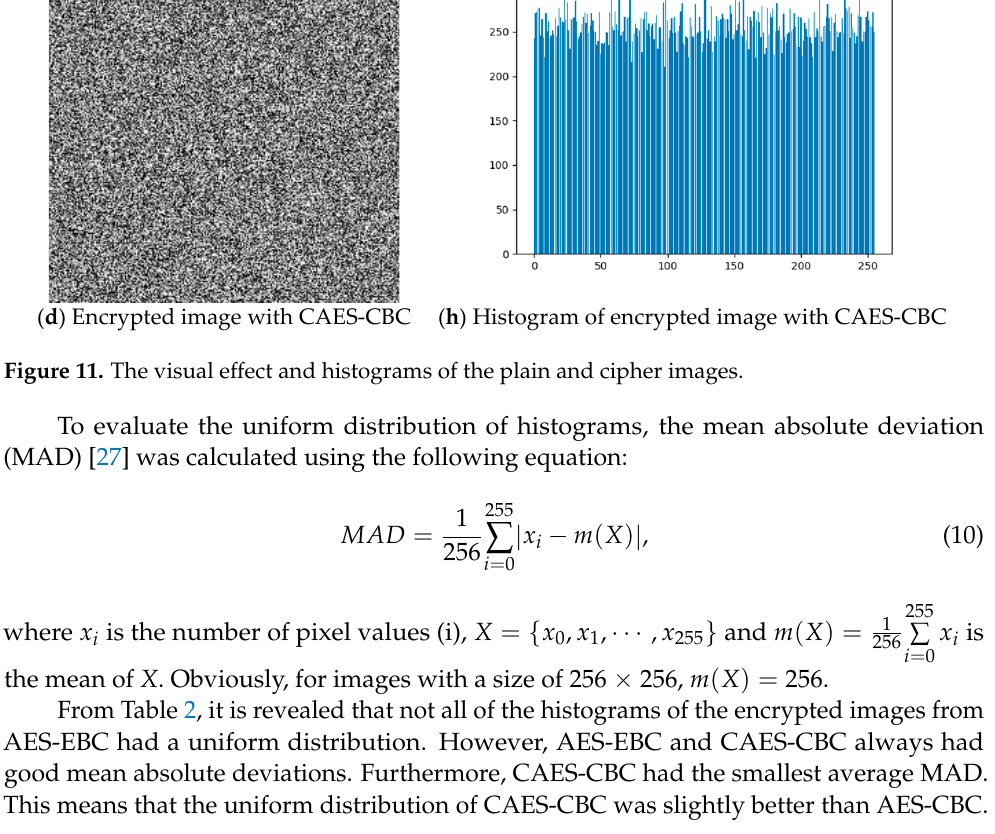
Table 2. Mean absolute deviation (MAD) uniform distribution test.